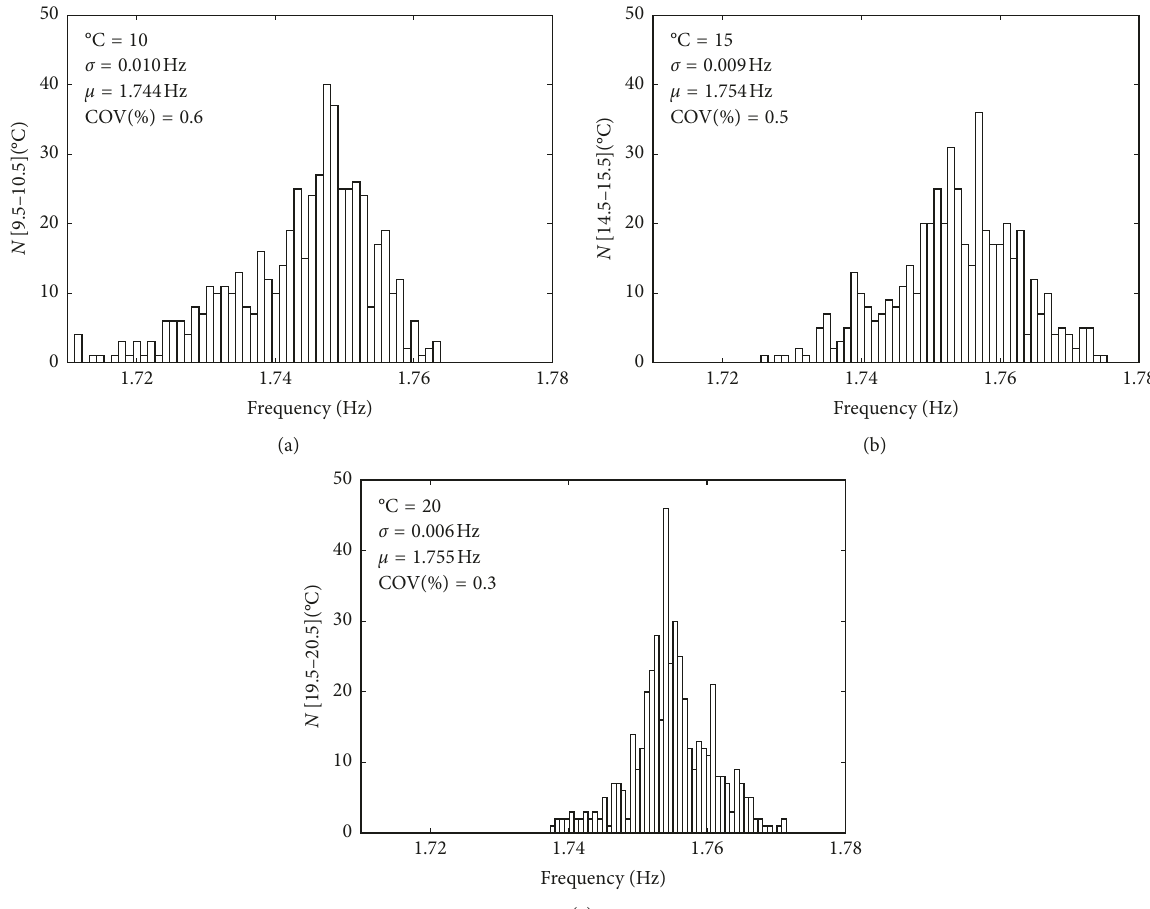
Figure 4: Distribution of the structural modal frequency recorded at OT over the learning phase for 10, 15, and 20 ° C.